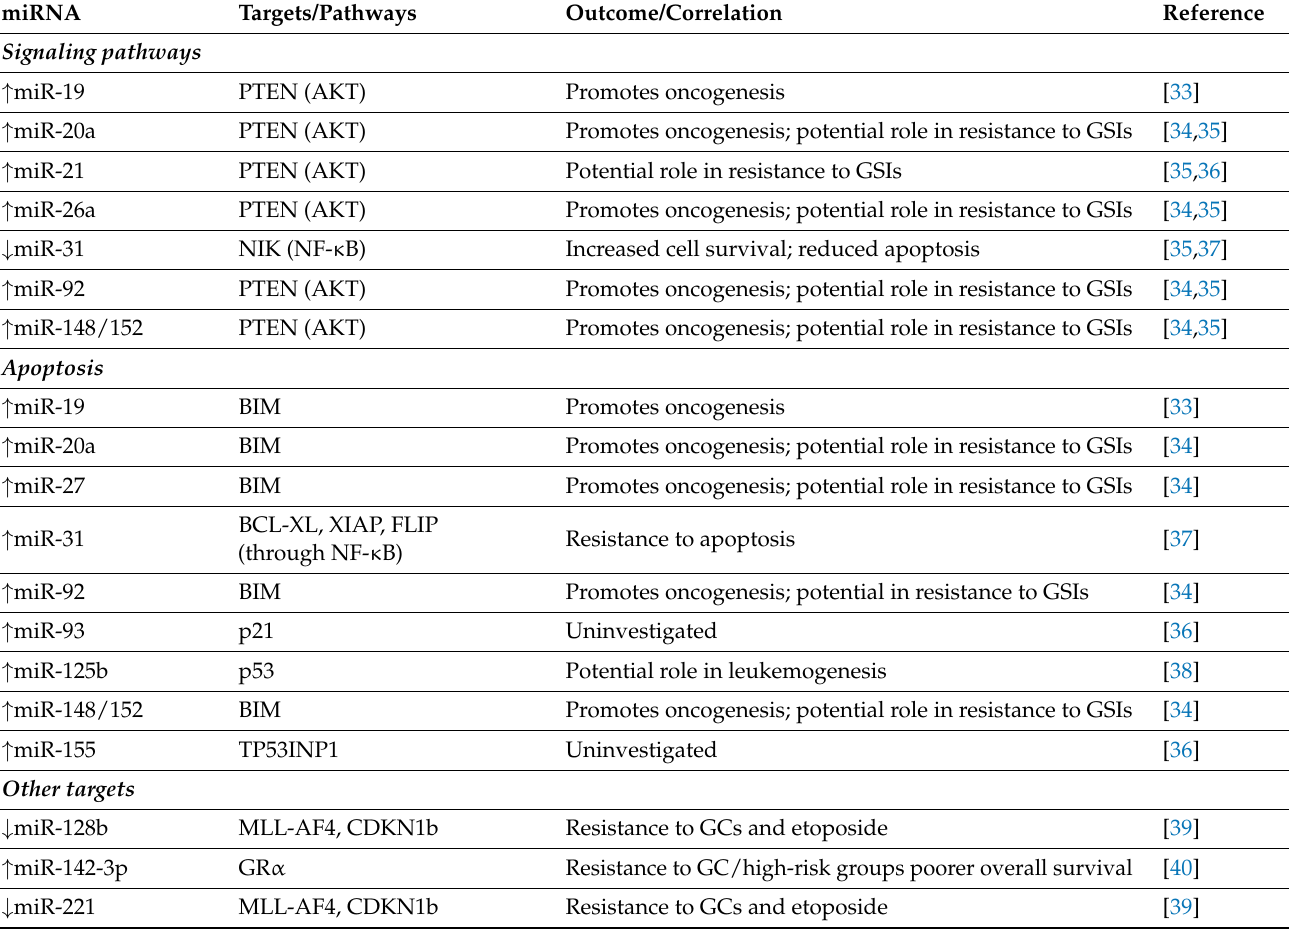
Table 1. miRNAs, their targets and their effects in adult